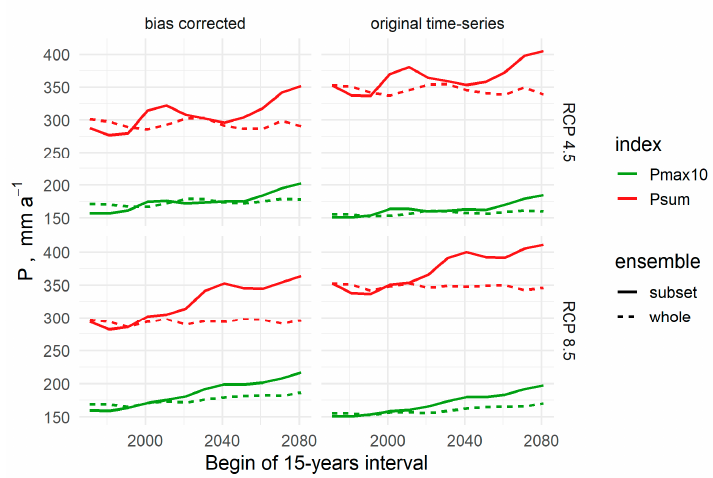
Figure 7. Trends of heavy and total rainfall sums averaged over 15 years and all stations. The bias correction resulted in lower total and slightly higher heavy-rainfall sums.